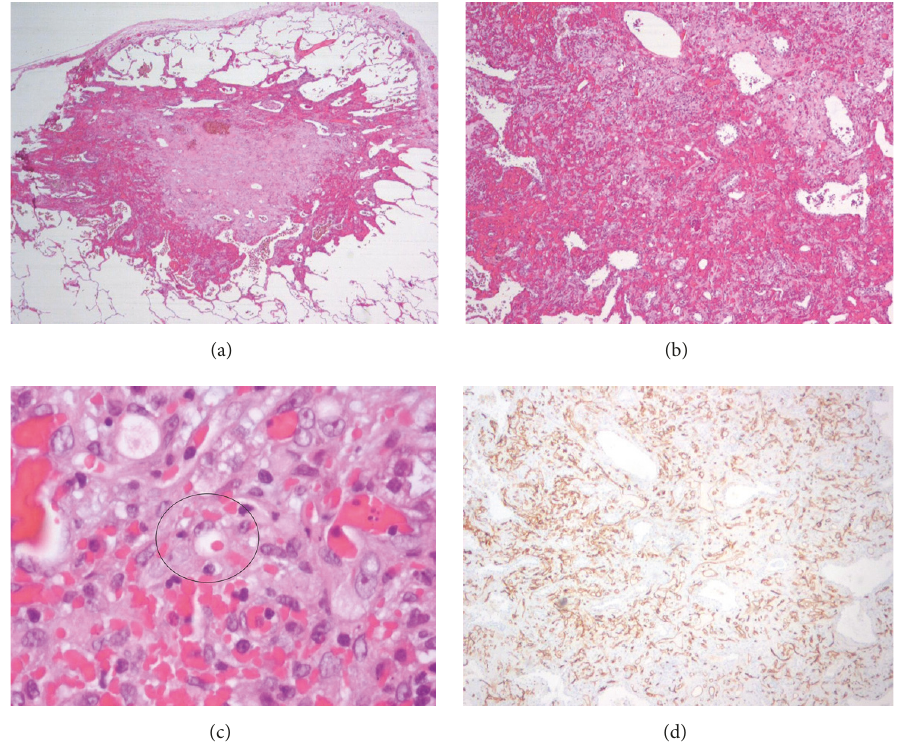
Figure 4: Histopathologic findings of hemangioendothelioma. (a) Low magnification of the specimen obtained from pulmonary wedge resection reveals a subpleural nodule that extends to adjacent alveoli, with vascular proliferation in the peripheral zone and areas of recent and old hemorrhage. (b) Neoplastic nodule showing tumor cells with an eosinophilic stroma at the periphery. The lesion contains blood filled spaces and respiratory epithelium “trapped” within the lesion is also shown. (c) Higher magnification of the tumor reveals vacuolation of some of the tumor cells, representing primitive angiogenesis. One of these epithelioid cells can be observed with intracytoplasmic lumen and an erythrocyte inside, indicating their vascular nature. (d) Immunostaining for CD34 revealed positivity of the neoplastic cells (brown colour), confirming the endothelial lineage of the tumor.